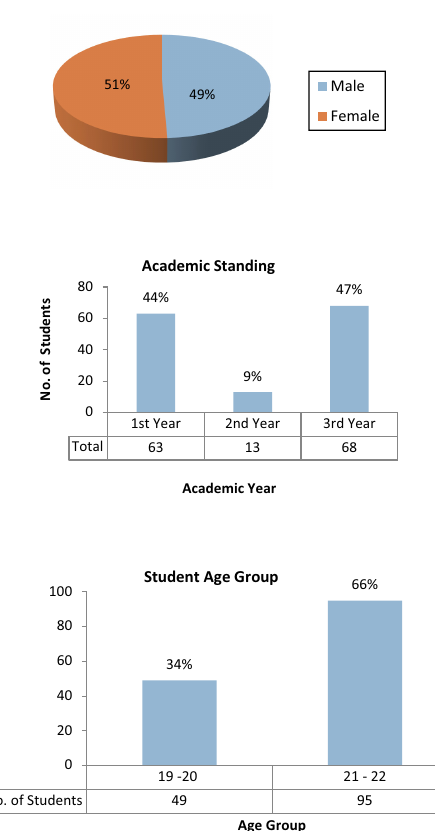
Figure 1. Gender composition